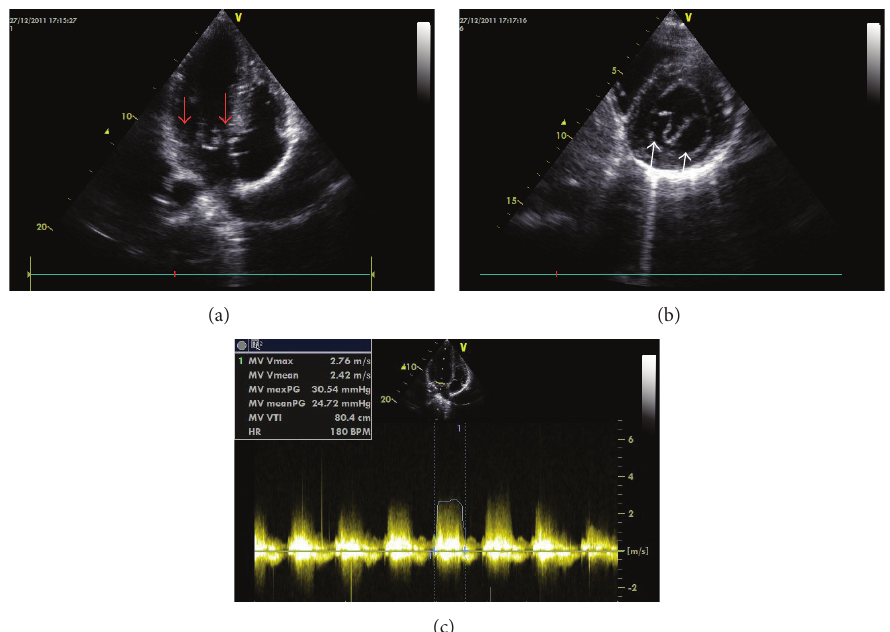
Figure 1: (a) Apical four-chamber view and (b) parasternal short axis view showing double orifice mitral valve. (c) Continuous wave Doppler tracings showing severe gradient over mitral valve.